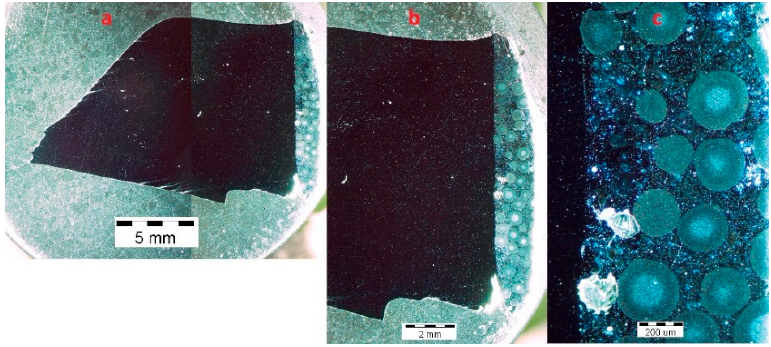
Figure 5. Cross section of a worn tooth with a protective carbide coating.